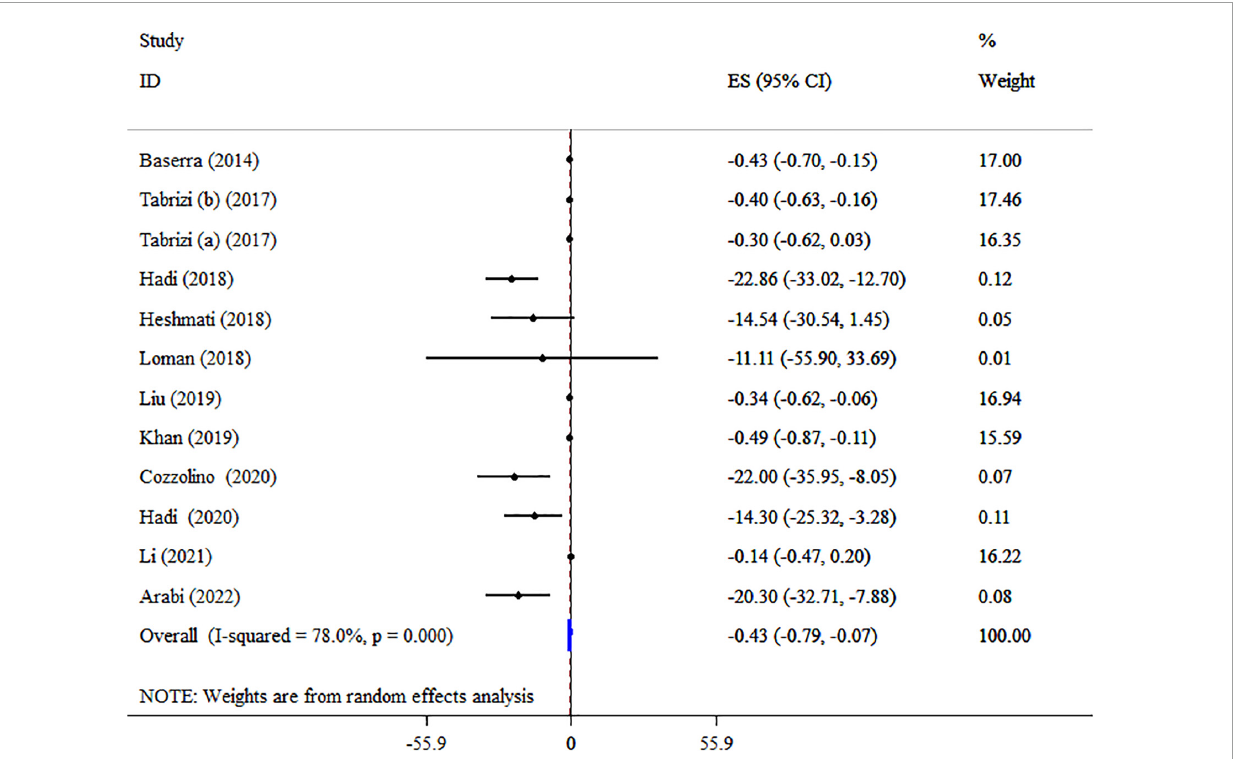
FIGURE7 Forest plot detailing mean difference and 95% confidence intervals (CIs), the impacts of synbiotic supplementation on TG levels.